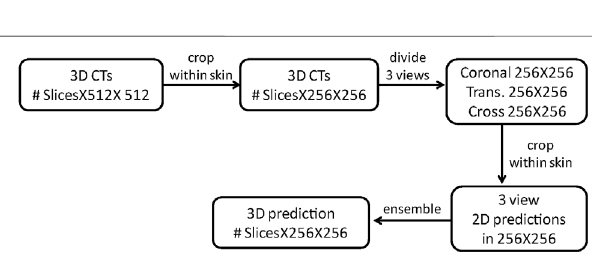
FIGURE 2 | Illustration of model ensemble strategy with shared network